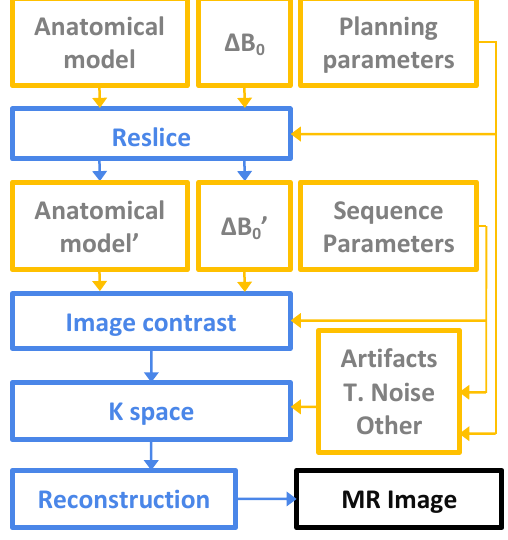
Figure 3. Block simulation